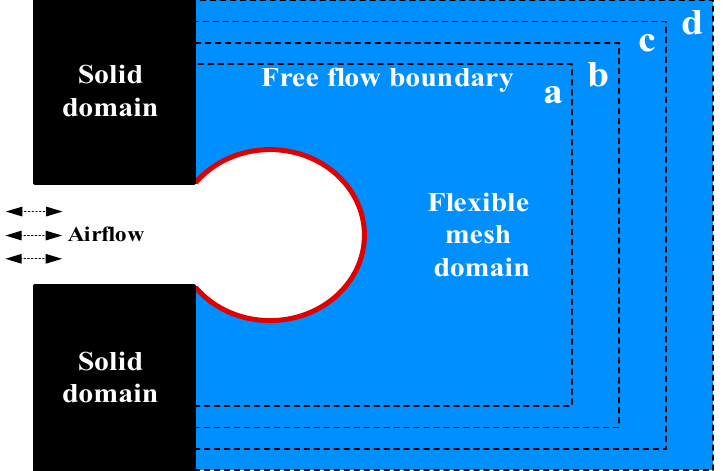
Figure 3. Grid independence verification model.